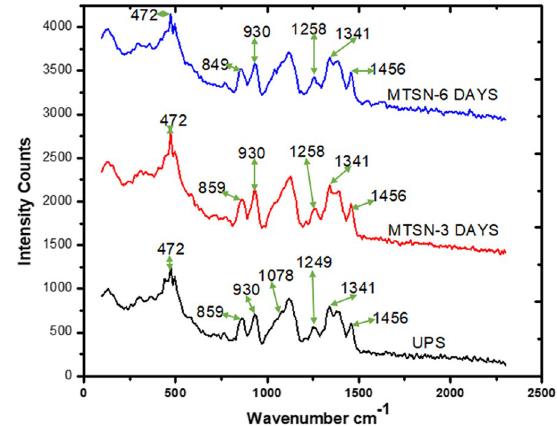
Fig. 8 The Raman spectra overlay of untreated starch and mechanically treated starches. The comparison of the Raman spectrum of untreated potato starch (UPS) versus mechanically treated starch nanoparticles